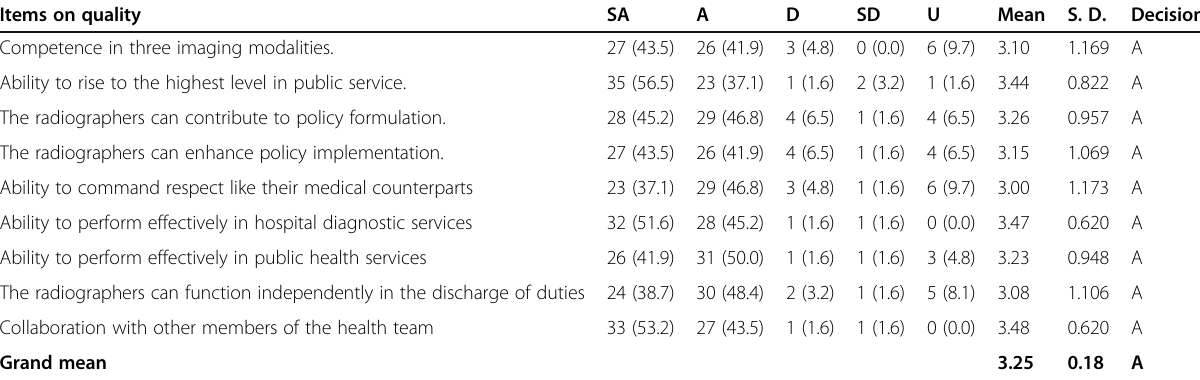
Table 3 Perception on quality of radiographers that will be produced by the program Items on quality Competence in three imaging